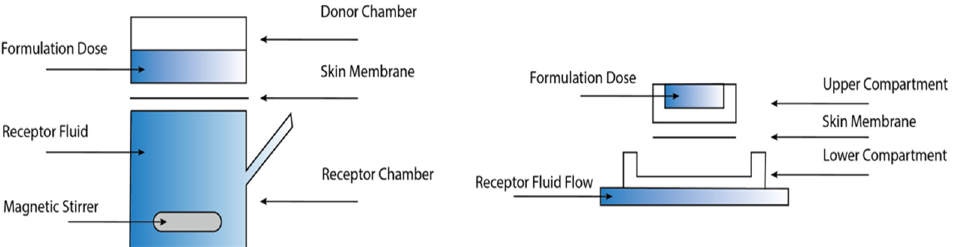
Figure 3. Schematic diagram of vertical diffusion cells (left: Franz cells; right: flow-through cells). Tom Franz, in 1975, validated the use of static glass diffusion cells to predict the in vivo percutaneous absorption and developed Franz cells [57]. In static Franz cells, magnetic stir mini bars are placed in receptor chambers to stir the receptor medium, which is collected and replaced with fresh medium at sampling time points. The experiment settings in IVPT studies using Franz cells include receptor volume, drug clearance, dosing area, chimney height of the donor chamber, etc. With the development of additive manufacturing technology, Sil et al. fabricated resin-based Franz cells with a 3D printer, allowing rapid and cost-effective customization of the IVPT experiment apparatus to meet optimized experiment settings [58,59]. However, no current model assesses penetration in a clinical-like setup. Over close to 50 years, there have only been a handful of attempts to develop diffusion cell donor chambers that mimic clinical settings. Wagner et al. established an in vivo/in vitro correlation for skin penetration of flufenamic acid dissolved in wool alcohol ointment by determination of the drug content in the stratum corneum and deeper skin layers of the same skin sample using Finn chambers for in vivo study and Saarbruecken penetration model/Franz cells for in vitro study [60]. A linear correlation of drug content between in vivo and in vitro was established for the deeper skin layers. A similar relationship was also observed in their earlier studies for the stratum corneum [61]. The other design of vertical diffusion cells is flow-through cells. In flow-through cells, the medium in the receptor chamber is continuously refreshed with a constant flow from the peristaltic or syringe pump connected to the reservoir of the receptor medium. It is desired that sampling at the initial stages of IVPT experiments is as frequent as possible to accurately quantify initial pharmacokinetics (i.e., permeability coefficient (Kp) and lag time (t lag )) [62]. Therefore, a higher flow rate may be required to produce a sufficient vol- ume of sample and maintain the sync condition. This, in turn, as a result of excessive dilution, can potentially induce the detection limit problem of permeants with slow release/penetration rate [63]. Thus, the clearance of flow-through cells, i.e., a ratio of flow rate and receptor volume, is one of the critical parameters, which often needs to be optimized to prevent detection limit problems in the earlier phase of the IVPT experiment circle. Tanojo et al. designed a novel flow-through cell with a spiral receptor chamber to reduce the influence of receptor volume and stagnant domains in the receptor chamber [64]. In the experimental set-up, there are two scenarios under which IVPT studies are performed, infinite dosage and finite dosage. For infinite dosing, a large amount of testing formulation is applied to the skin. The formulation loss caused by evaporation and skin absorption is considered negligible compared to the dosing amount. For semisolid prod- ucts, a crust formation in the top layer evaporated also delays further metamorphosis. Under finite dosing, only a limited amount of formulation (smaller than 10 µL/cm²) is applied to the skin to mimic the in-use conditions [56]. To predict the “in use” penetration profile of metronidazole semisolid products under clinical conditions, Arora et al. devel- oped a physiologically based pharmacokinetic model of metronidazole using IVPT data, which successfully captured the metamorphosis of metronidazole gel and cream after ap- plication [65]. The influence of evaporation of volatiles and gradual change in vehicle